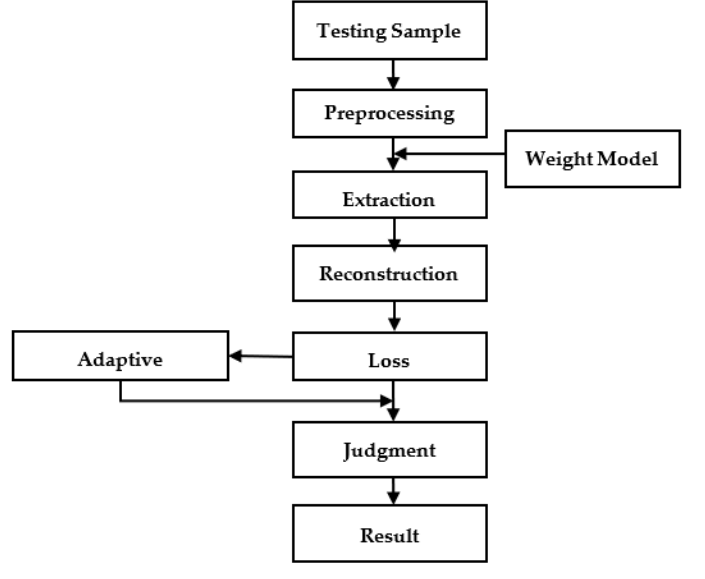
Figure 6. Model testing algorithm flow.